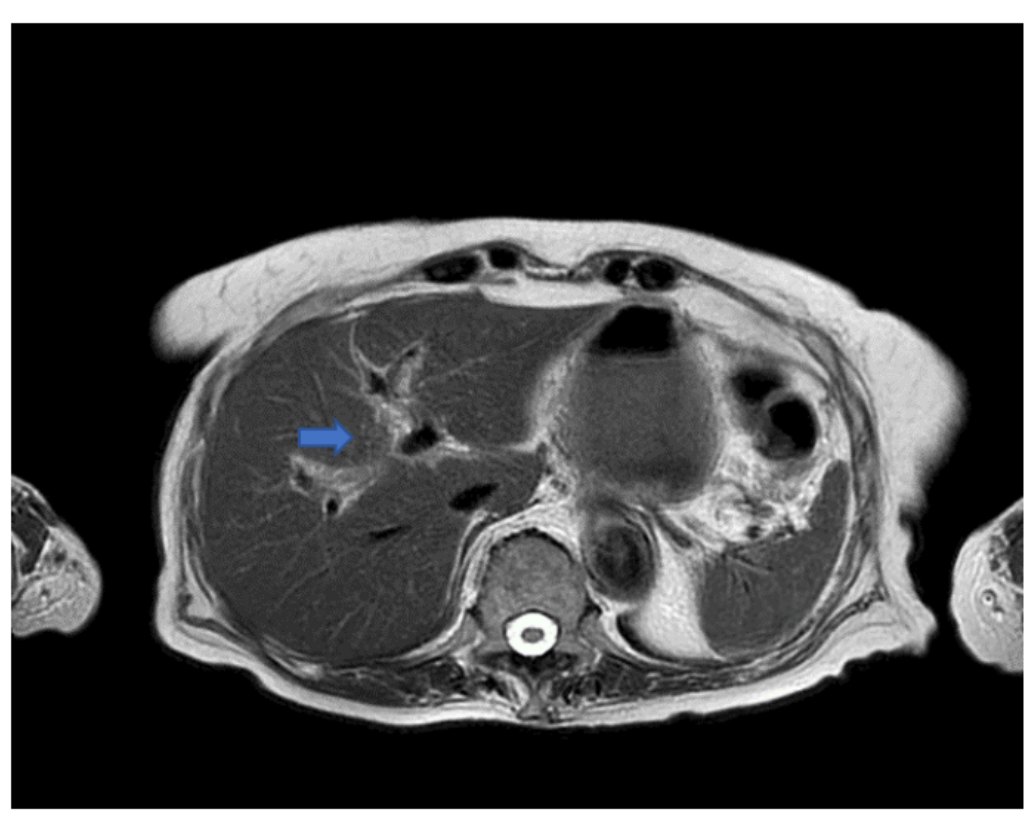
Figure 2. T2 weighted image (TR 2258 ms TE 100 ms) that does not show any alteration of caliber of the intrahepatic ducts (blue arrow).